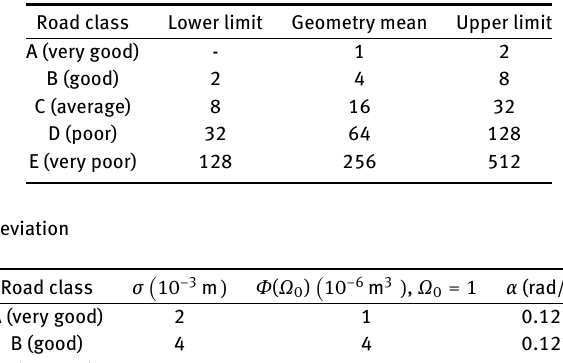
Table 2. Road roughness values classifiedby ISO (degree of roughness Φ ( Ω ) × 10 −6 )